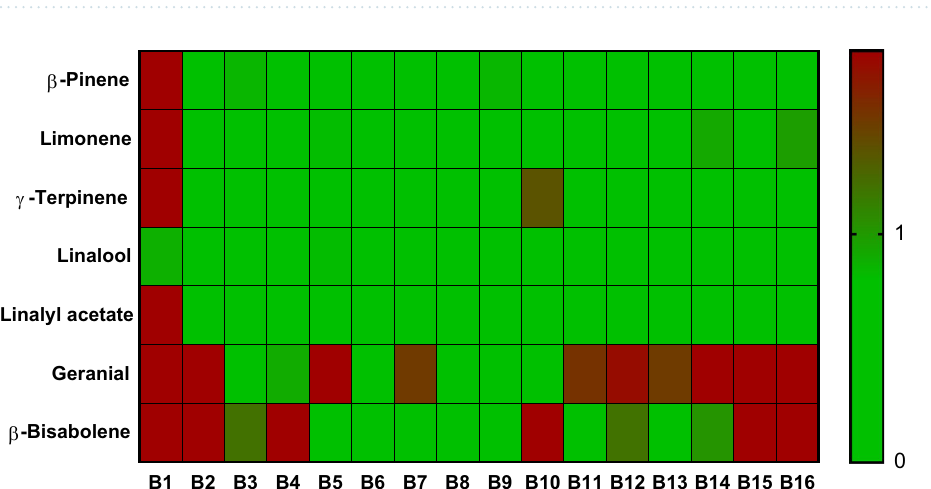
Figure 6. Heat map of relative scores of bergamot essential oils for relevant compounds according to ISO 3520. B11 and B12 were obtained from reputable